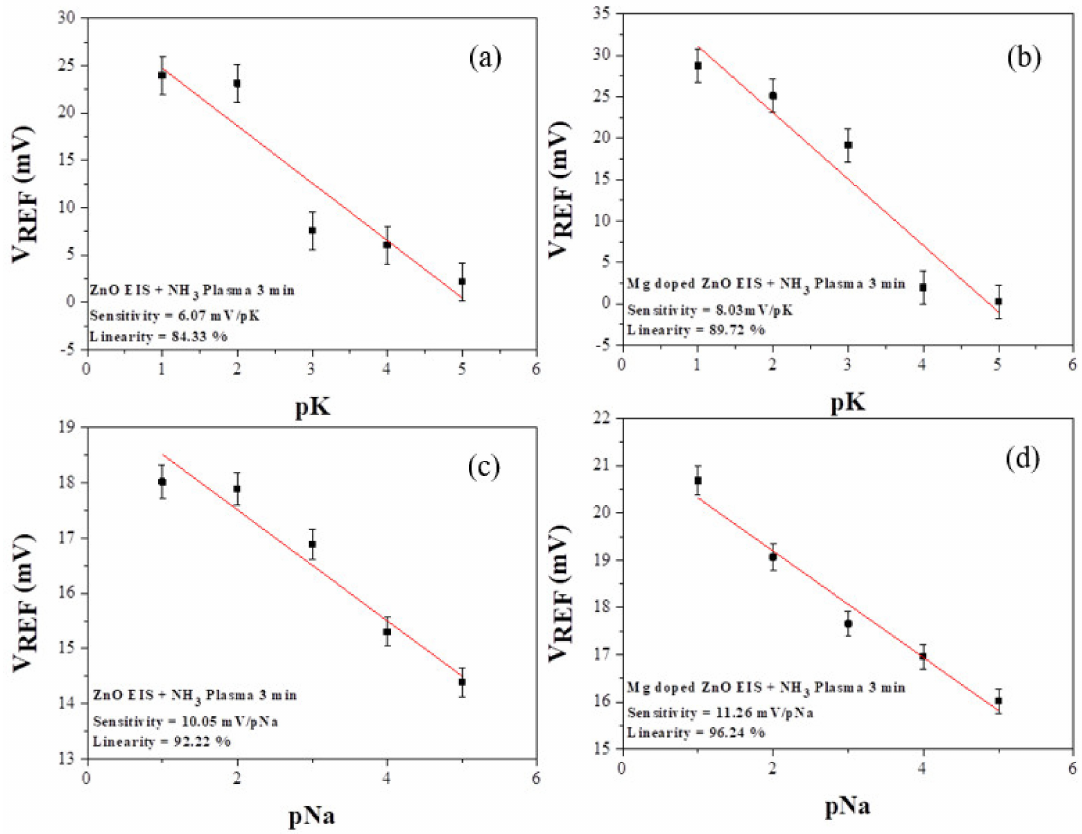
Figure 7. Sensing attribute of ( a , b ) K + and ( c , d ) Na + by ZO and MZO treated with NH 3 plasma for 3